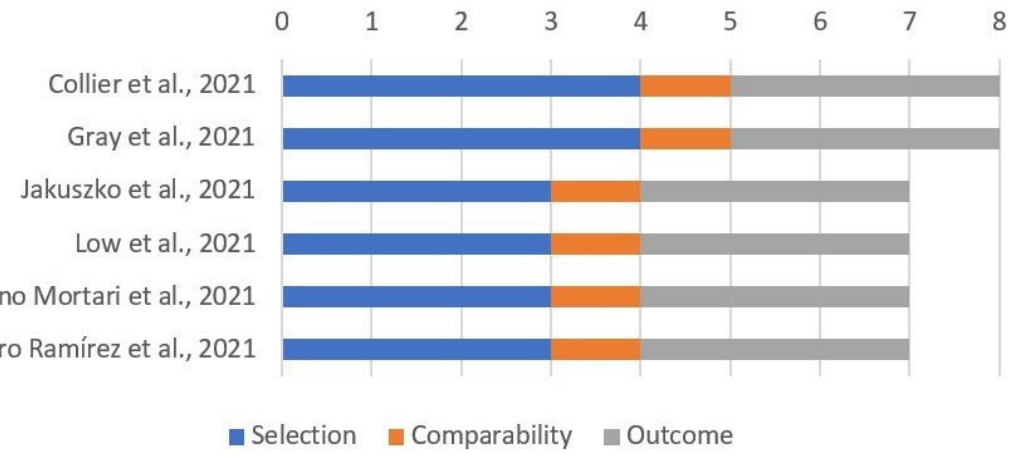
Figure 3. Quality assessment of included cohort studies involving pregnant women through “Newcastle–Ottawa Scale for cohort studies”.